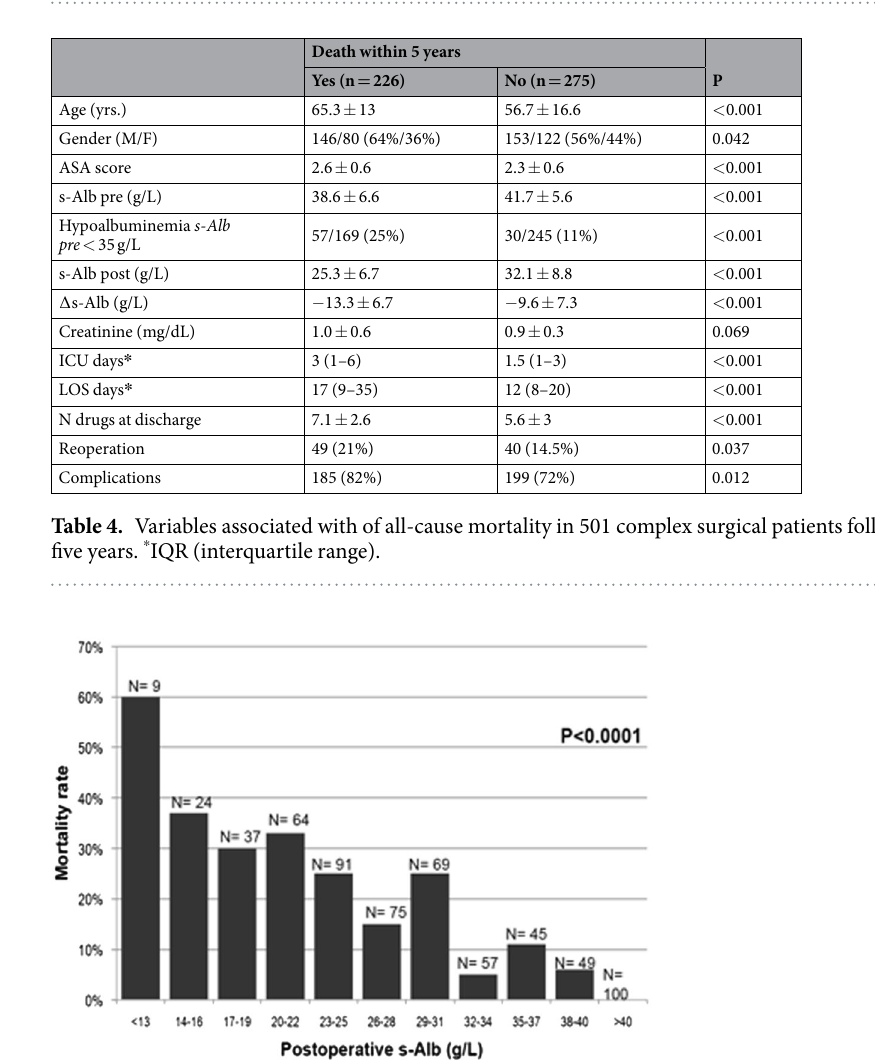
Table 3. Multivariate analysis (binary logistic regression) of predictive variables of postoperative and long-term mortality.